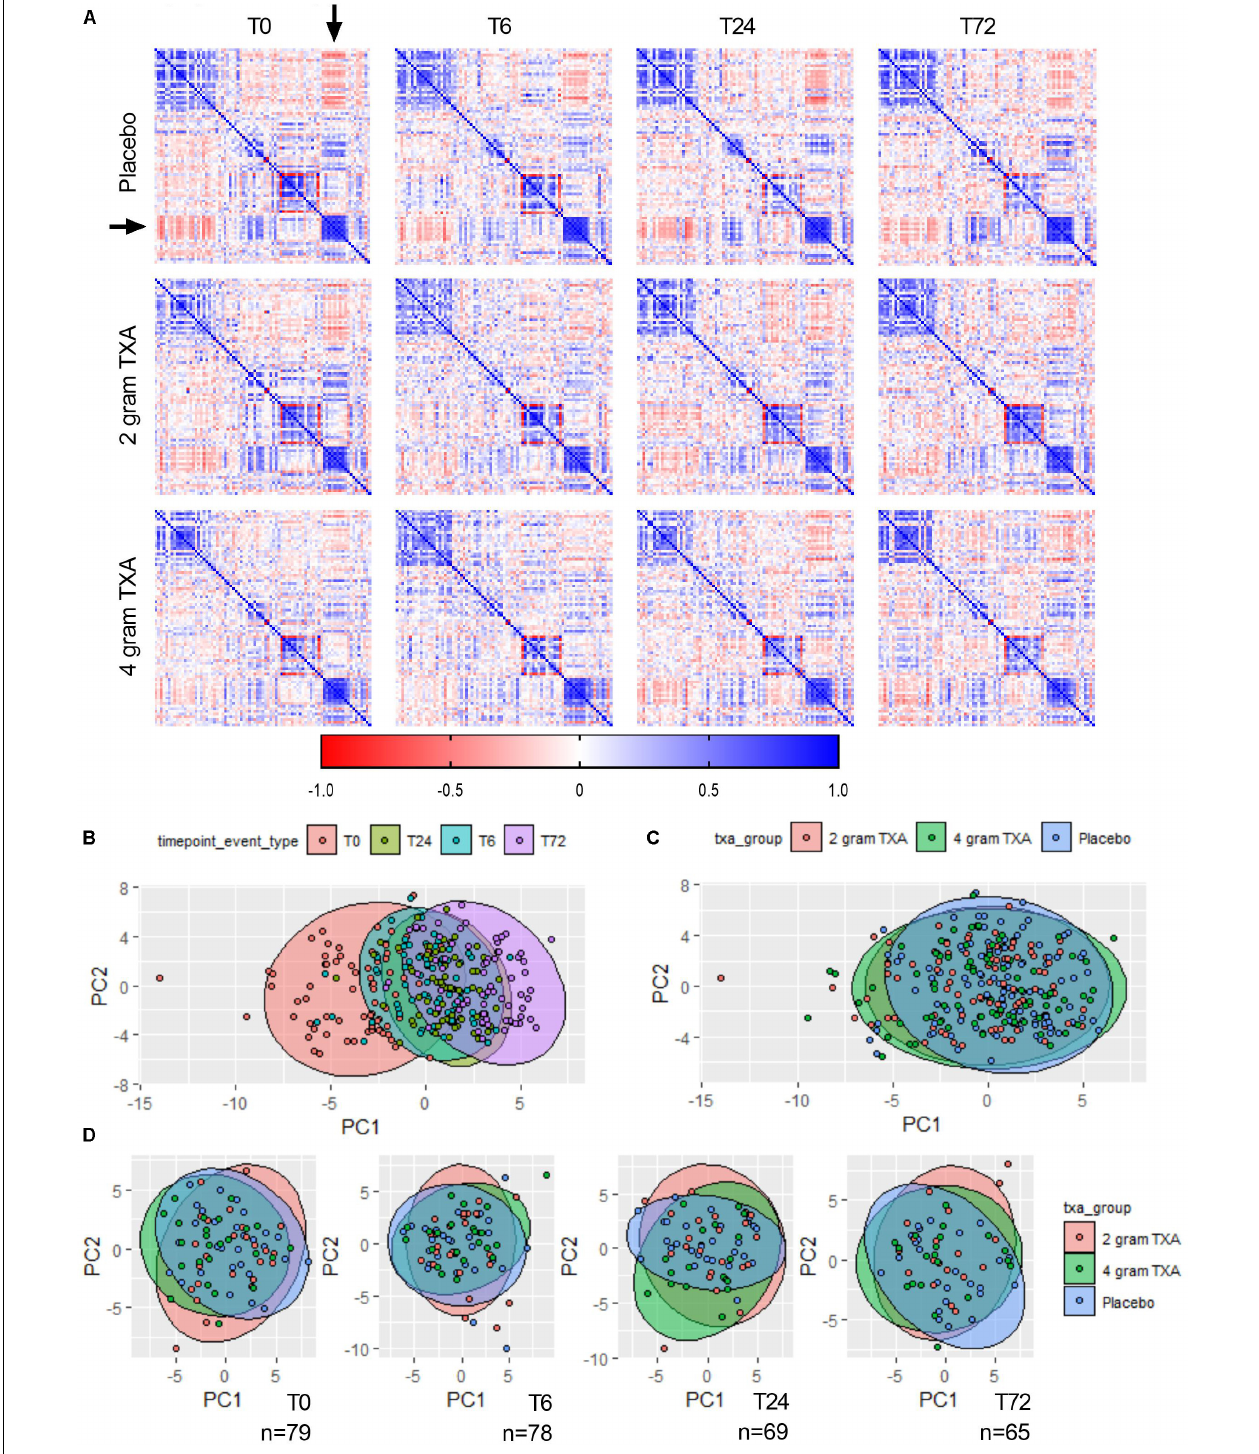
FIGURE 9 | The effects of trauma, and not of TXA administration, impart the greatest impact on immune and hemostatic phenotypes in traumatically injured bleeding patients. (A) Correlation matrices at each time point for each study group were built using the variables listed in Supplementary Table S7 . Positive correlation is denoted in blue, while a negative correlation is denoted in red. Principal component analysis (PCA) labeled by (B) sampling time point (“timepoint_event_type”; T0, T6, T24, and T72; n = 283), (C) treatment group (“txa_group”; Placebo, 2 g TXA, 4 g TXA; n = 283), or (D) at a given time point by treatment group. For PCA, confidence ellipses are set at